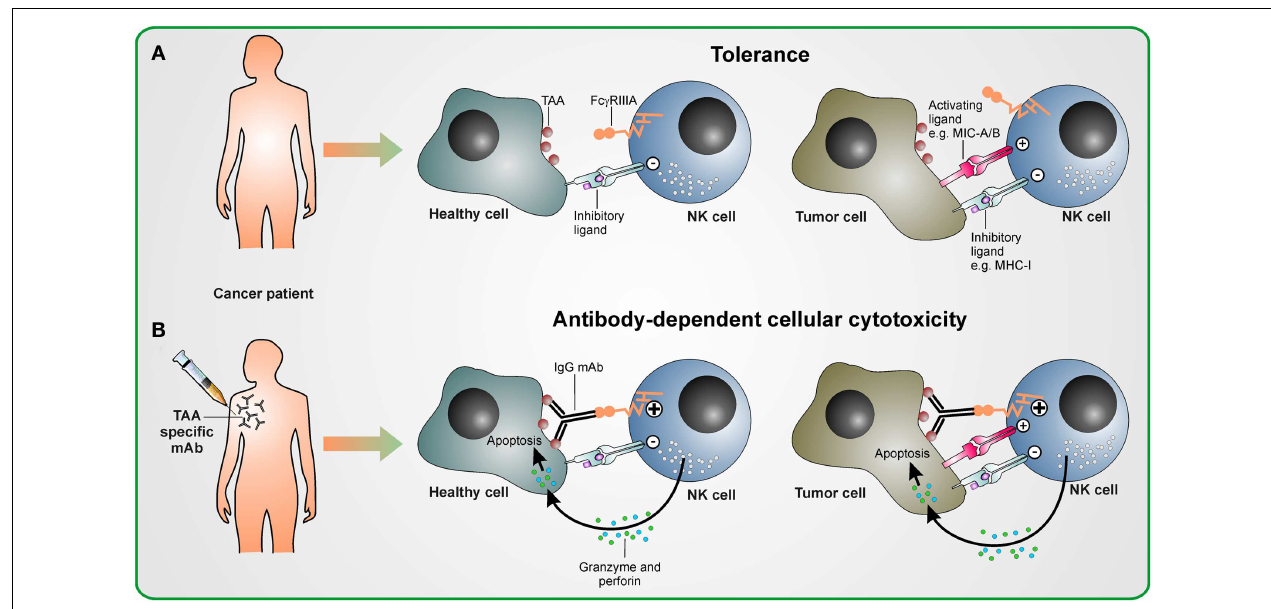
class I molecules. (B) Upon treatment with tumor antigen-associated (TAA) specifc antibody, the activating stimulus from Fc γ RIIIa induced by antibodies cross-linking NK cells withTAA-expressing healthy and malignant cells overcomes inhibitory signals.This leads to the activation of NK cells and ADCC is mediated by releasing cytotoxic granules containing perforin and